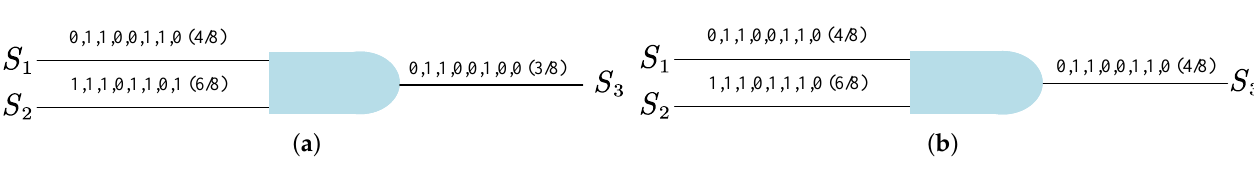
Figure 7. A demonstration of stochastic computing. ( a ) is an accurate computing process of two irrelevant number. By contrast, ( b ) shows an incorrect value but not the result see a great gap to the accurate one, which means the effects will be negligible.